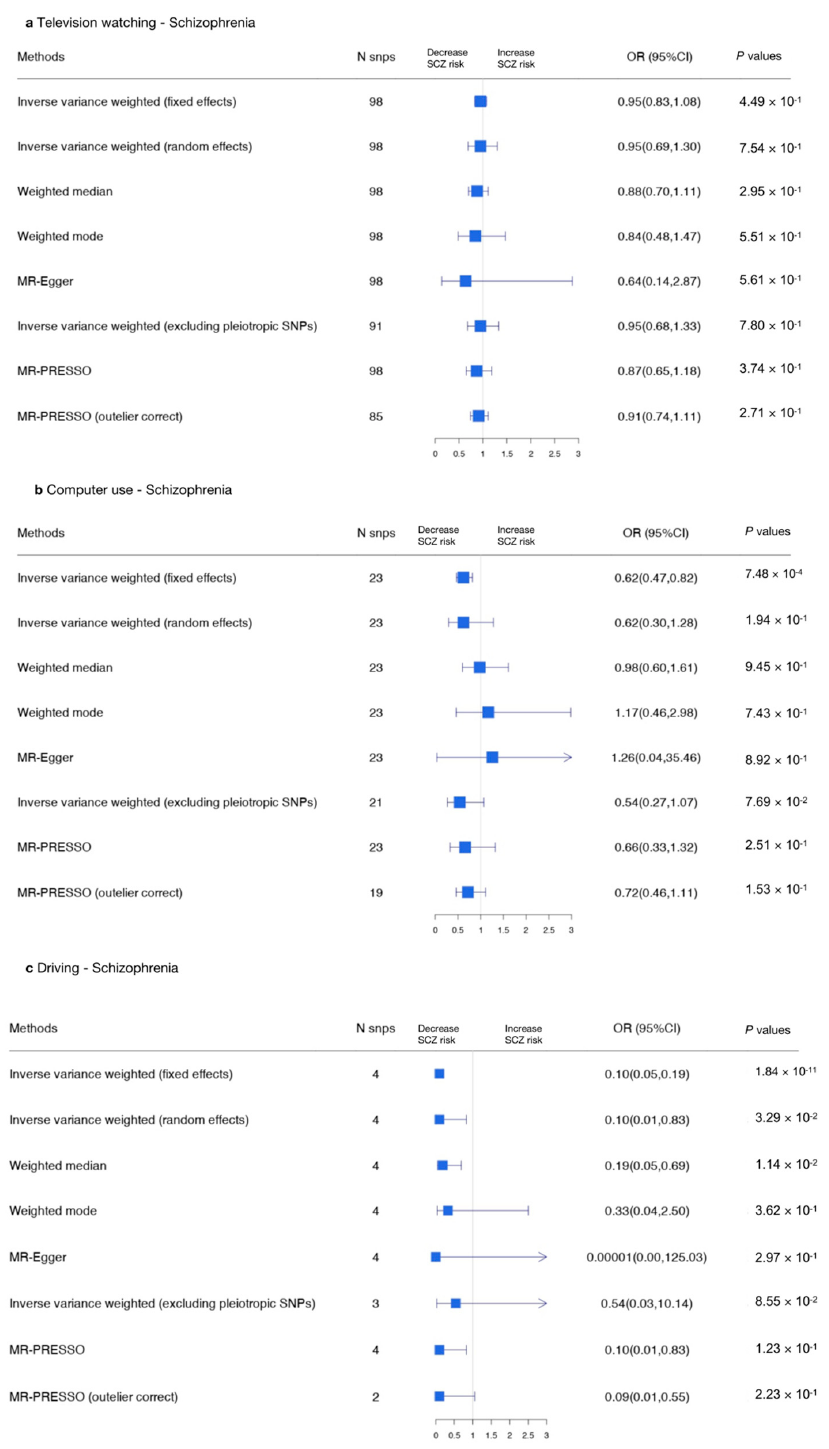
Figure 4. Summarized Mendelian randomization (MR) effect sizes between sedentary behaviors and SCZ. Summarized MR effect sizes of the causal relationship between ( a ) television watching time, ( b ) computer use time, and ( c ) driving time and SCZ were estimated using the following approach. The methods used in the analyses included IVW, IVW removing genetic variants with a potentially pleiotropic effect in any phenotype, MR-Egger, weighted median, MR pleiotropy residual sum and outlier (MR-PRESSO), outlier-corrected MR-PRESSO, and weighted mode methods. Odds ratios (ORs) as well as 95% confidence intervals (95% CIs) are presented on the x axis. A two-sided p -value of less than 0.05 was considered statistically